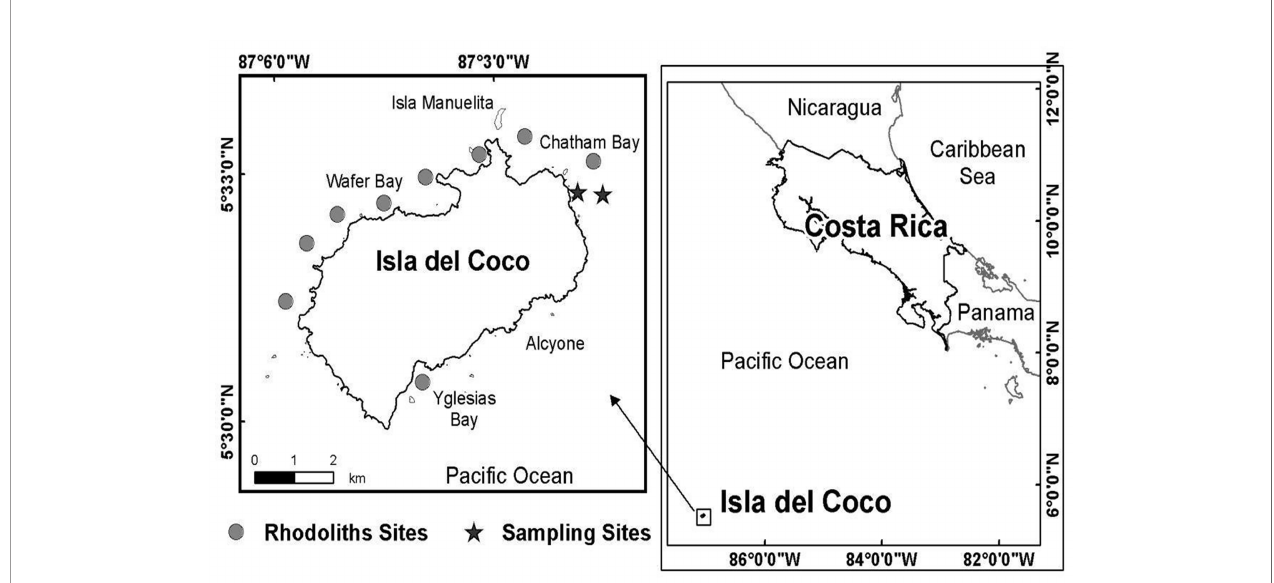
FIGURE 1 | Isla del Coco, Costa Rica (Eastern Tropical Paci fi c). Circles are rhodolith beds and the stars correspond to the rhodolith bed sampled (two areas: one with more dispersed rhodoliths nearest to the coastline and the other with more grouped